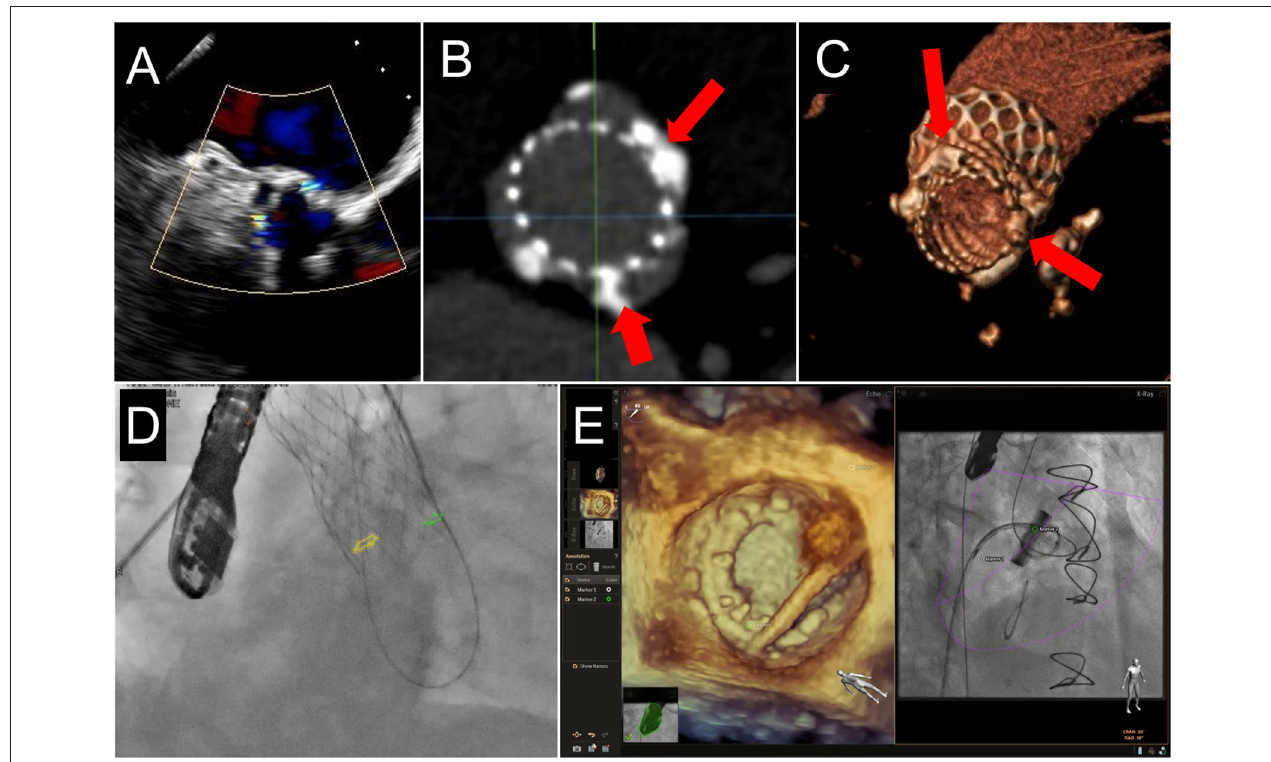
FIGURE 7 | Fusion Imaging. 2 PVL jets are seen on TEE color Doppler imaging in a patient who had previously undergoing TAVR (A) . These were anatomically located on subsequent CCTA ( B,C , red arrows) and co-registered onto fluoroscopic procedural imaging ( D , yellow and green circles). (E) A mitral PVL closure using live TEE fusion imaging for